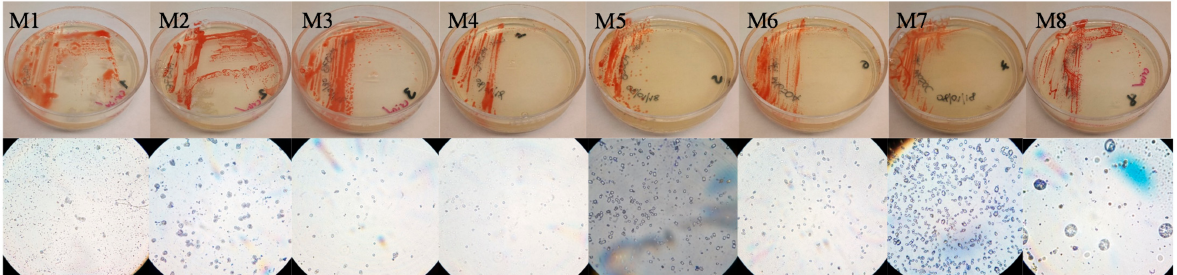
Figure 3. Petri and microscope pictures of the eight